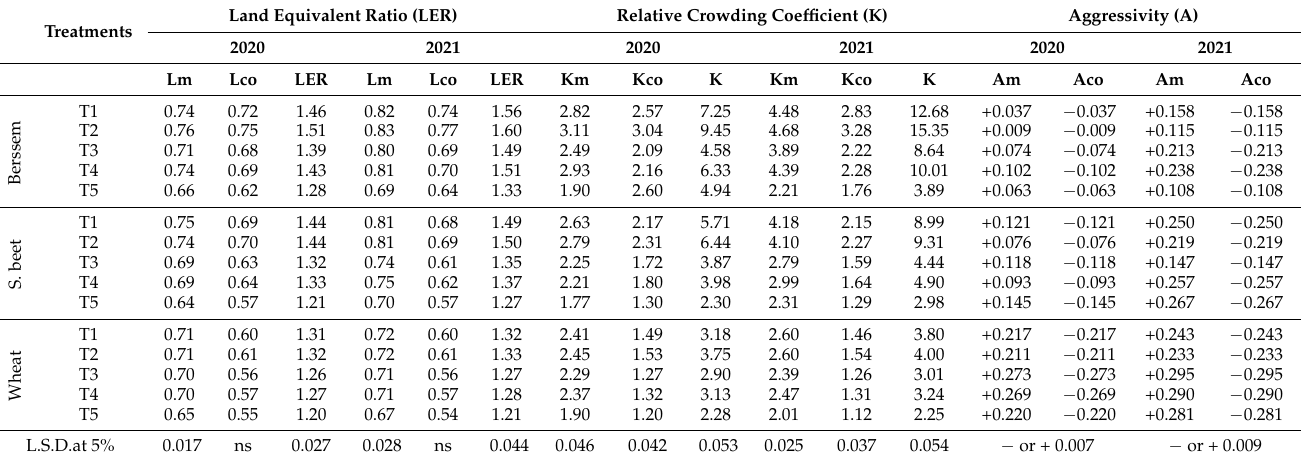
Table 9. The effect of preceding crops and NPK as well as biofertilizers on land equivalent ratio (LER), relative crowding coefficient (K) and Aggressivity (A) for maize intercropping with cowpea during 2020 and 2021